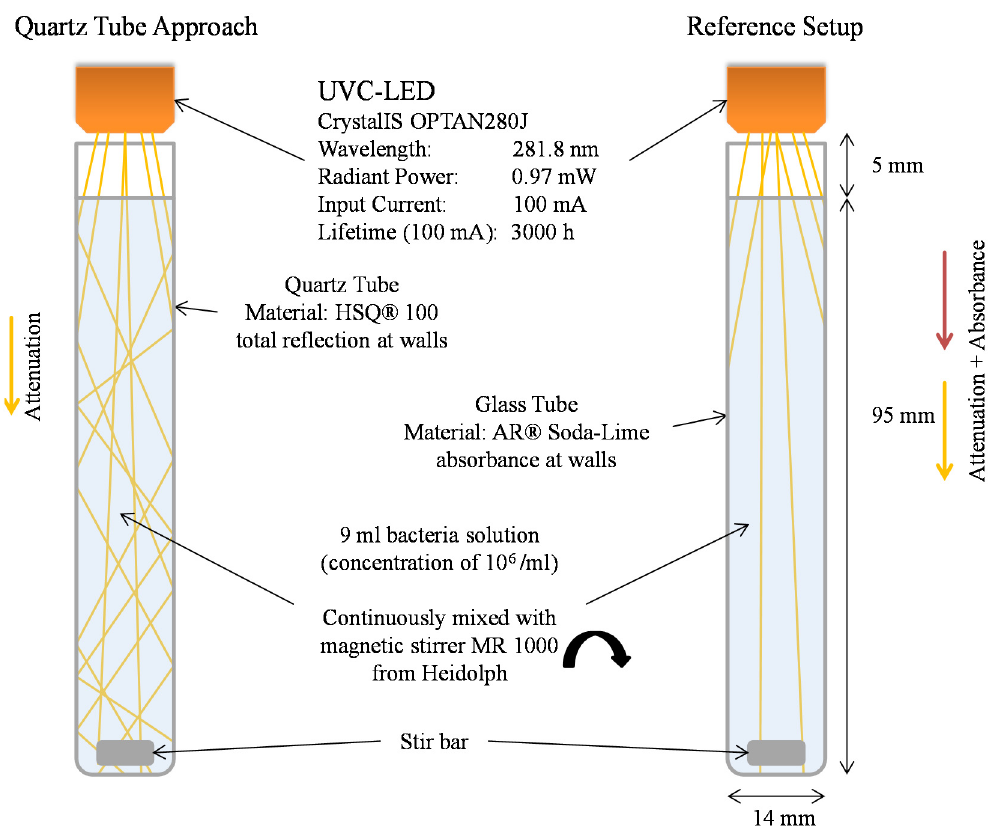
Figure 2. Schematic illustration of the designed experimental setup: ( left ) novel approach utilizing HSQ ® 100 quartz glass for total reflection and ( right ) reference setup with AR ® glass for quantification of the disinfection enhancements of this